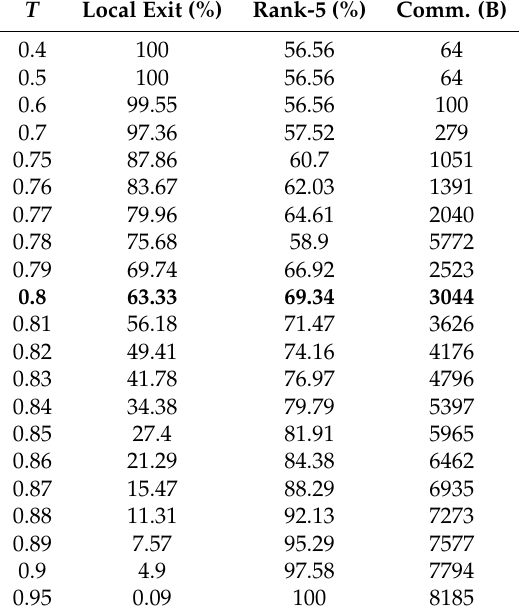
Table 4. While local network L = 16, the effects of different exit thresholds ( T ) settings for the local. T = 0.8 is used in L =